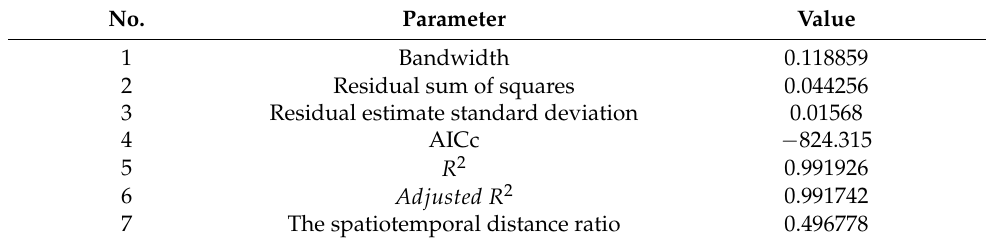
Table 2. Relevant parameters of